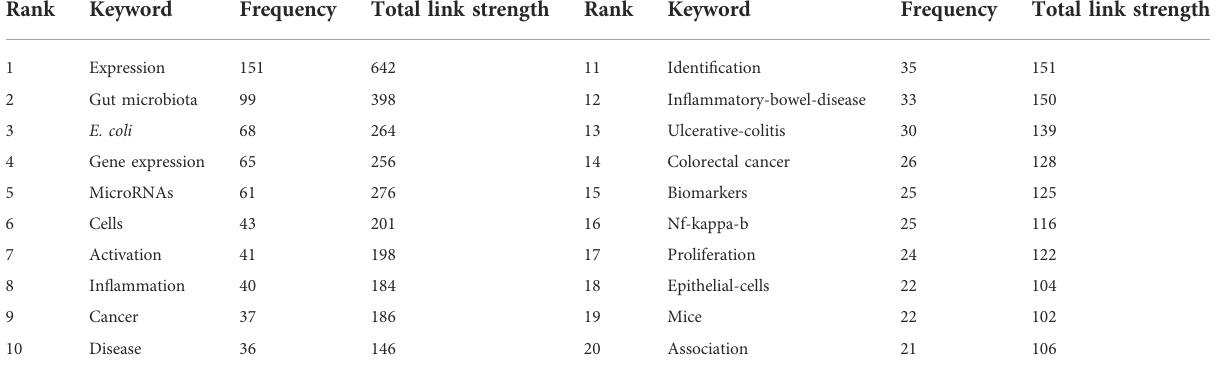
TABLE 4 Top twenty occurrence analysis of keywords on miRNA-microbiome interaction research.